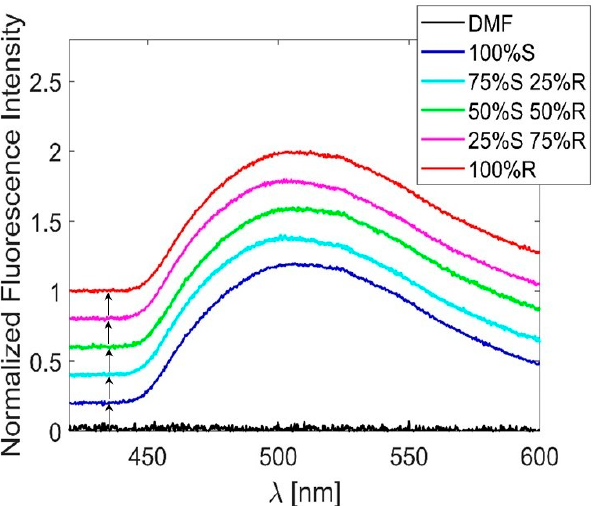
Figure 4. Fluorescence for different relative concentrations of enantiomer solutions in DMF, under linearly polarized excitation at 400 nm. The fluorescence intensities are normalized to their own maximum value and translated by a factor of 0.2 in order to increase the curve visibility. As a reference, we also report the measurements for DMF alone, which, as expected, did not produce any luminescence.